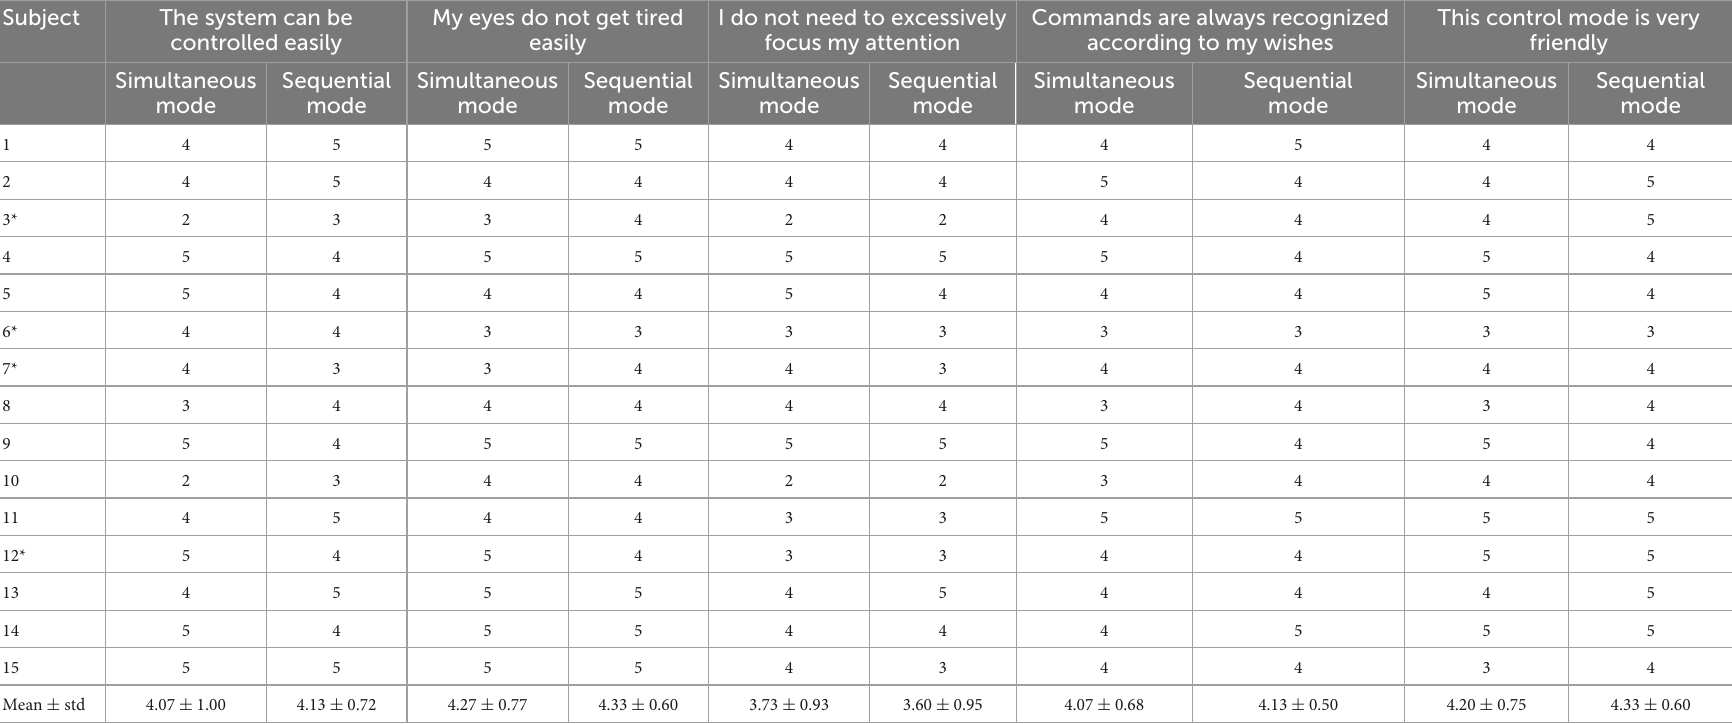
TABLE 2 Subjective evaluation results of each subject on two